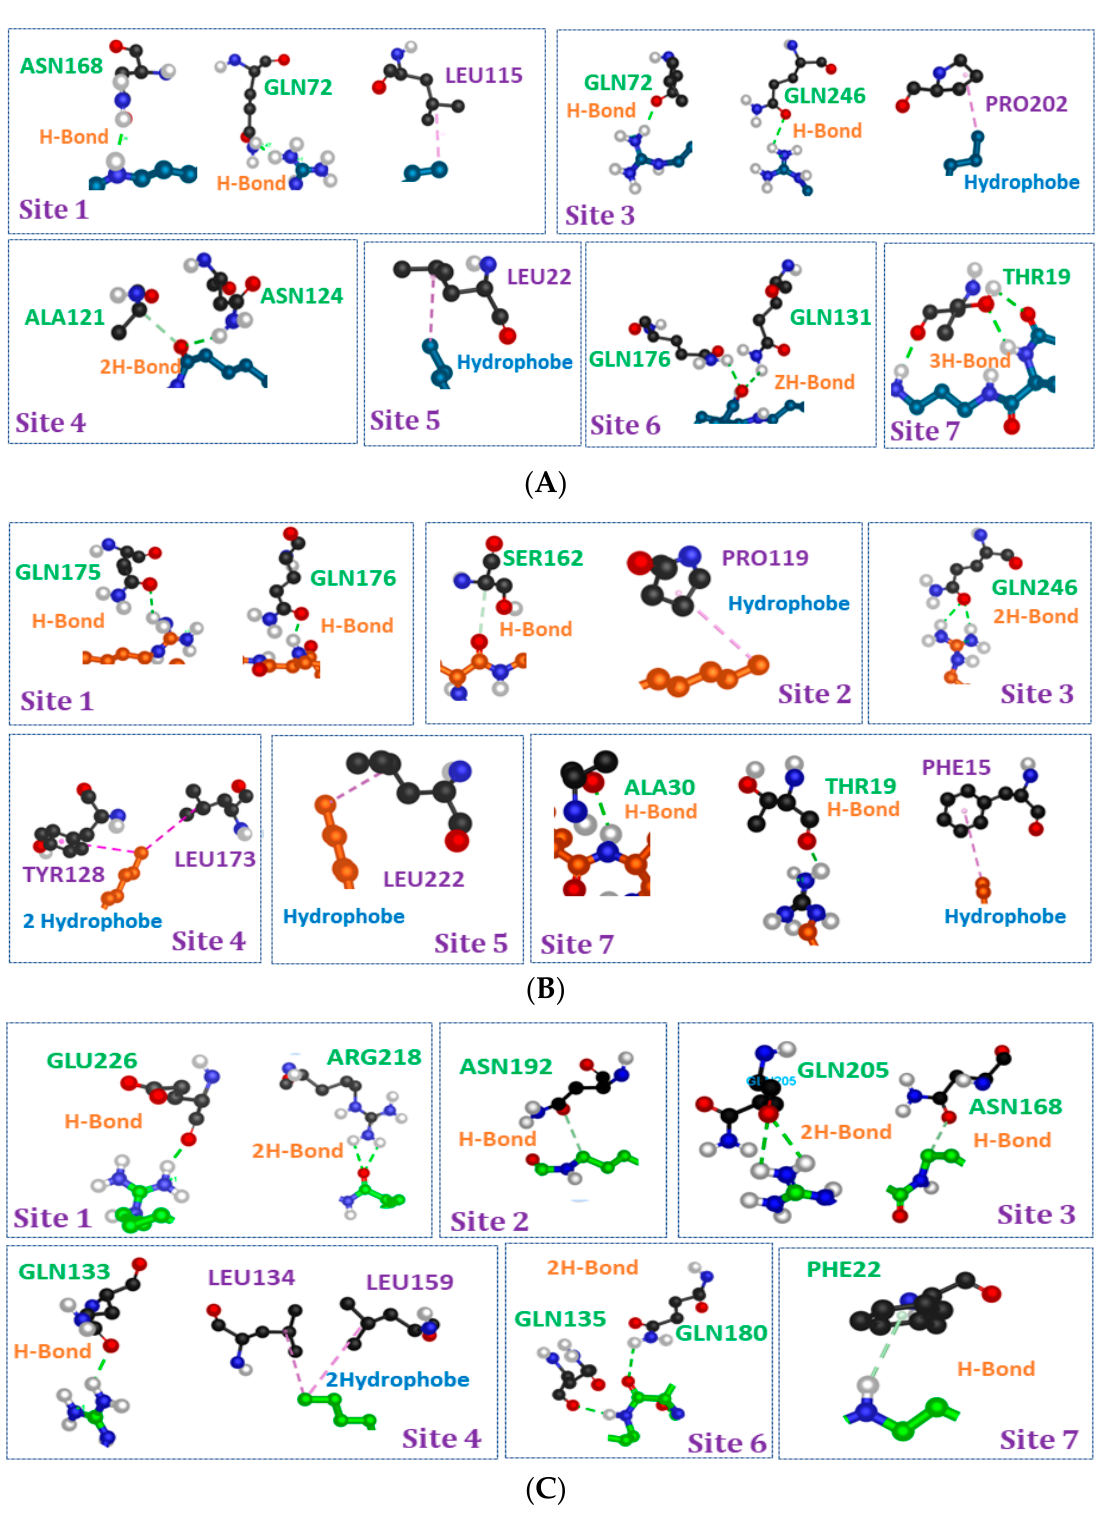
Figure 10. Different types of interaction on the surface of the zein structures (Q9SYT3_MAIZE) in different binding sites for ( A ): C 3 (LA) 2 ( B ): C 6 (LA) 2 and ( C ): C 9 (LA) 2 .